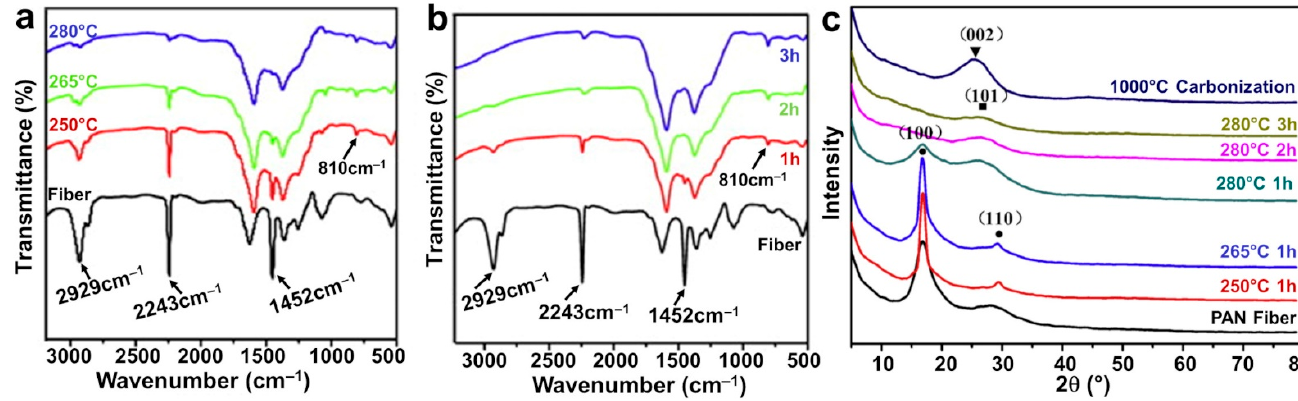
Figure 8. ( a , b ) FTIR spectra of stabilized PAN nanofibers (heating rate of 2 °C min − 1 in a constant air flow): ( a ) temperature effect (holding time: 1 h); ( b ) time effect (holding temperature: 280 °C). ( c ) XRD patterns of the PAN precursor nanofibers, the stabilized (under air), and the carbonized PAN nanofibers (2 °C min − 1 until 1000 °C for 1 h stay under N 2 atmosphere). Reprinted and adapted with